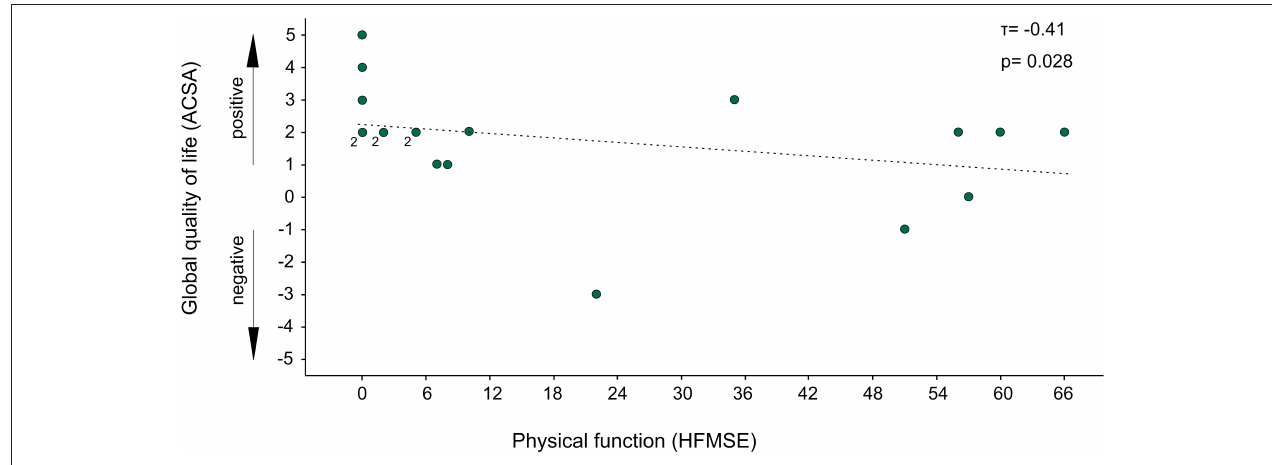
FIGURE 2 | Association of global quality of life with physical function. N = 19; Global quality of life (gQoL) was evaluated with Anamnestic Comparative Self-Assessment (ACSA), where values above zero indicate (max. + 5) a positive well-being, while values below zero (min. − 5) indicate a negative well-being; Physical function was evaluated with Hammersmith Functional Motor Scale Expanded (HFMSE) with values from 0 (minimum physical function) to 66 (maximum physical function); data points labeled “2” represent 2 patients; higher qQoL was significantly associated with lower physical function ( τ = − 0.41, p =